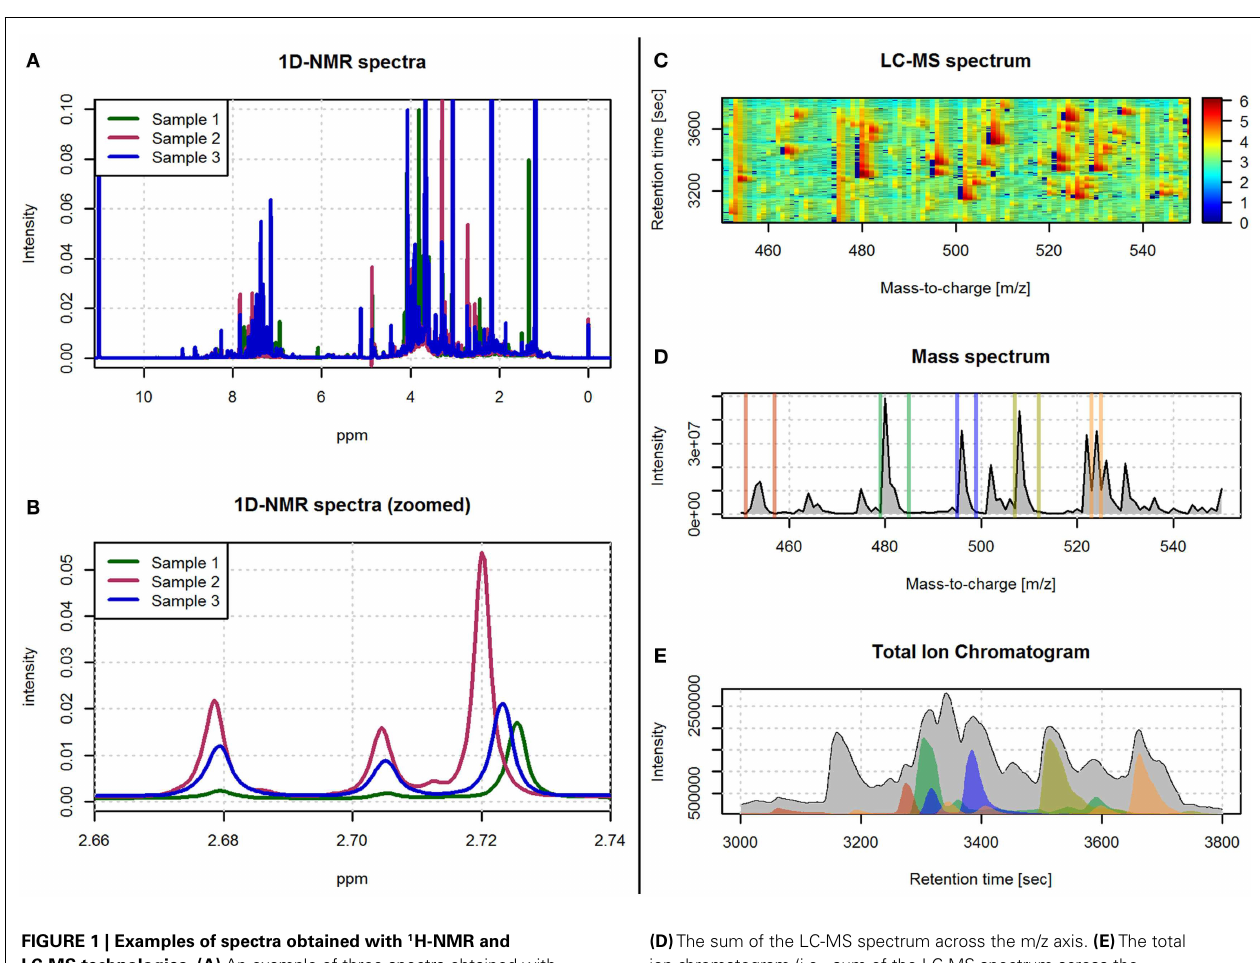
FIGURE 1 | Examples of spectra obtained with 1 H-NMR and LC-MS technologies . (A) An example of three spectra obtained with 1D 1 H-NMR. (B) A zoomed view of the spectra in (A) in the 2.66–2.74ppm range. (C) An example of a LC-MS spectrum with color-coded intensity and referred by the m/z and retention time axes.